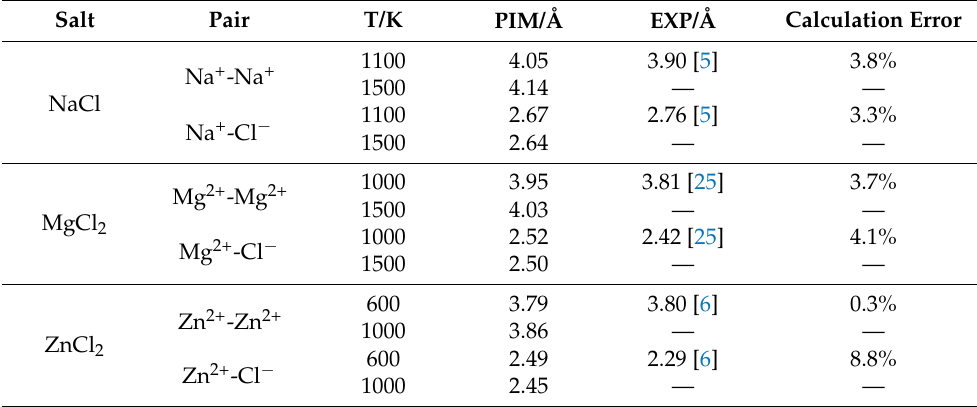
Figure 2. Coordination number in different temperature of molten chloride salts: ( a ) NaCl; ( b ) MgCl 2 ; ( c ) ZnCl 2 . Table 4. First peak positions of RDF for molten chloride